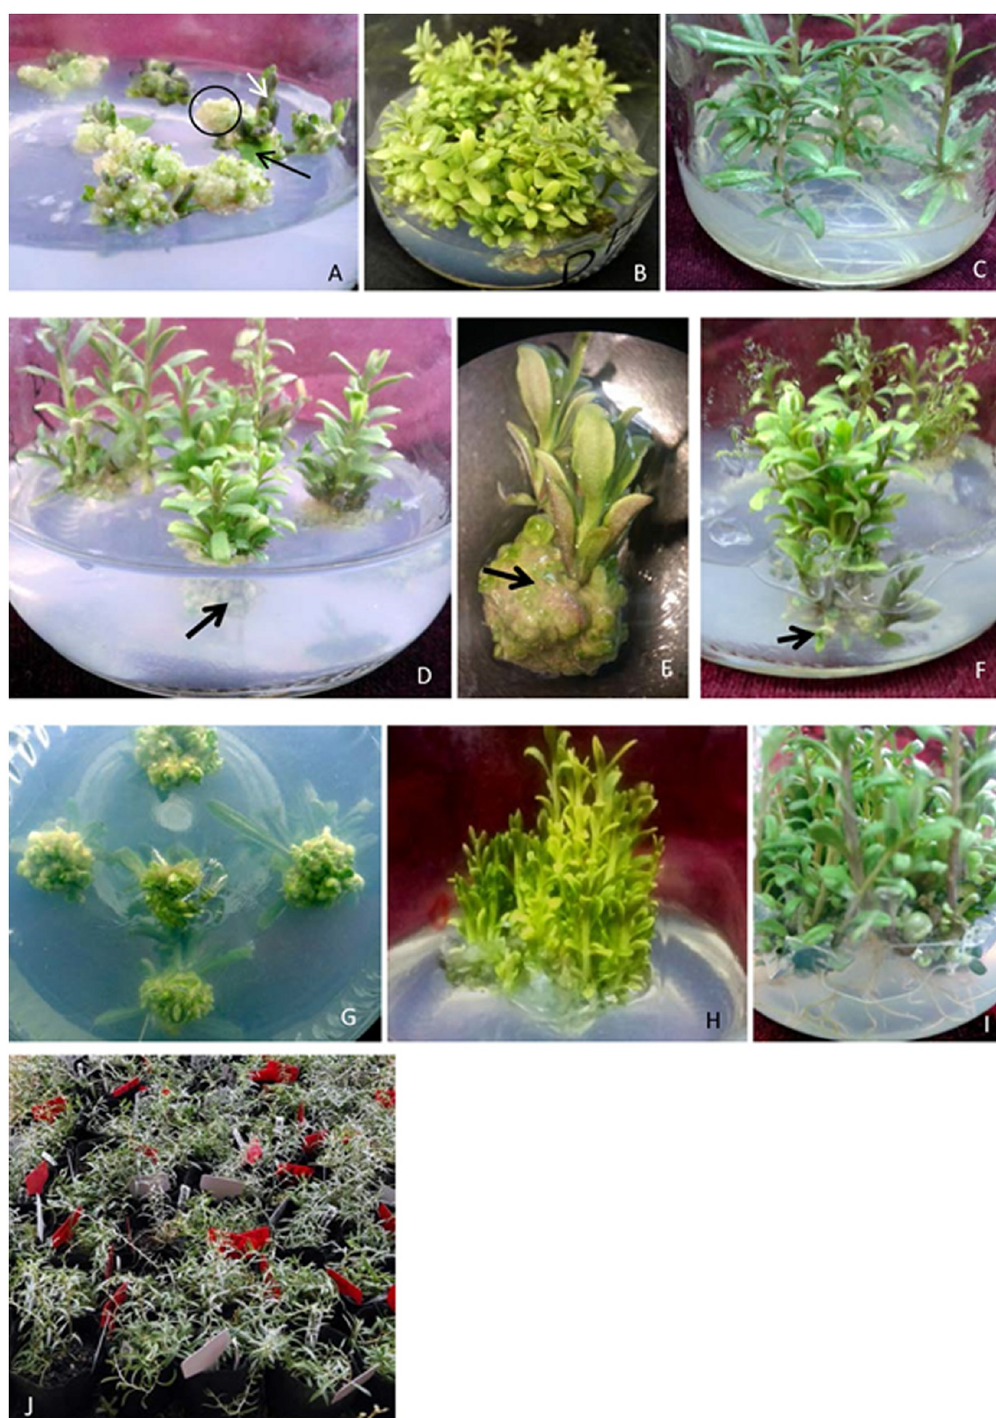
Fig 3. Plant regeneration of L . ruthenium from leaves and stems. (A) Callus (circle) and adventitious buds (white arrow) derived from leaf explant (black arrow); (B) Rosette shoots from leaf callus; (C) The rooted plantlets from leaf explants; (D) Multiple shoots from axillary bud and nodular callus (black arrow) from cross section of stem explant; (E) The nodular callus (arrow) was magnified; (F) (G) Adventitious buds (arrow in F) from nodular callus of stem explant; (H) All the shoots from a single stem explant; (I) The rooted plantlets from stem explant; (J) Plantlets after acclimatization.